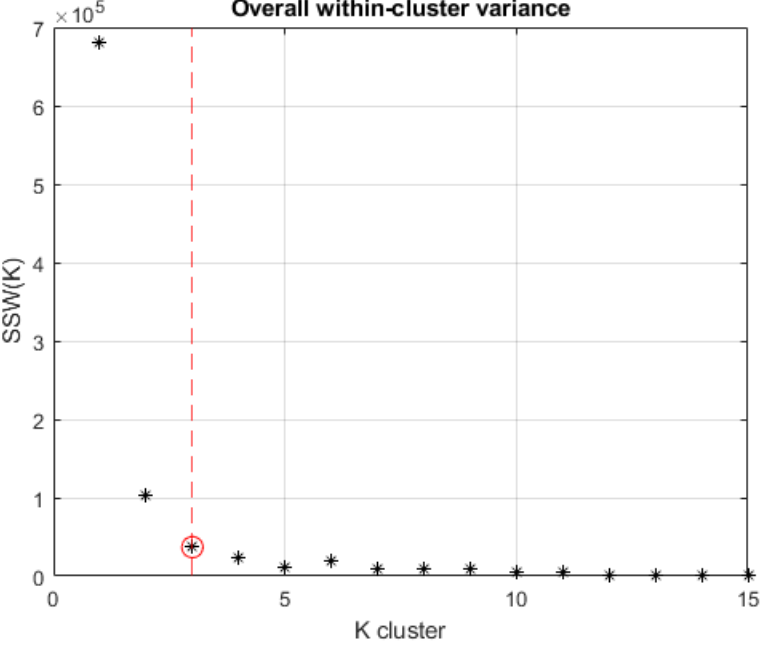
Figure 9. Kneedle algorithm results applied to K -means ++ method.